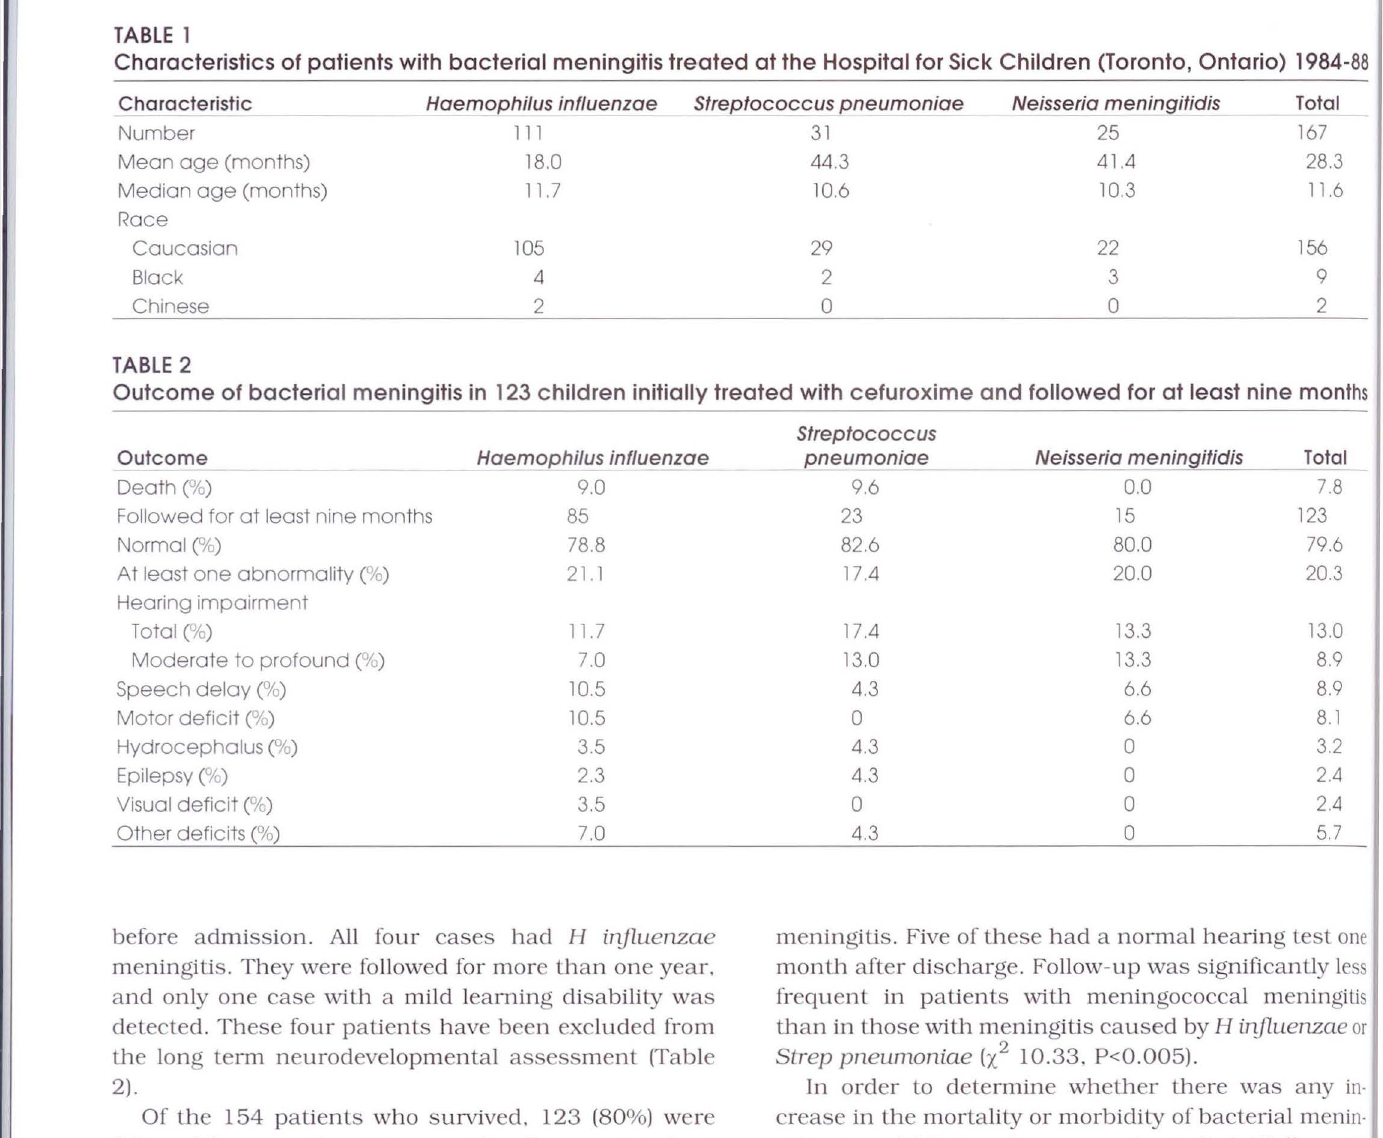
Outcome of bacterial meningitis in 123 children initially treated with cefuroxime and followed for at least nine